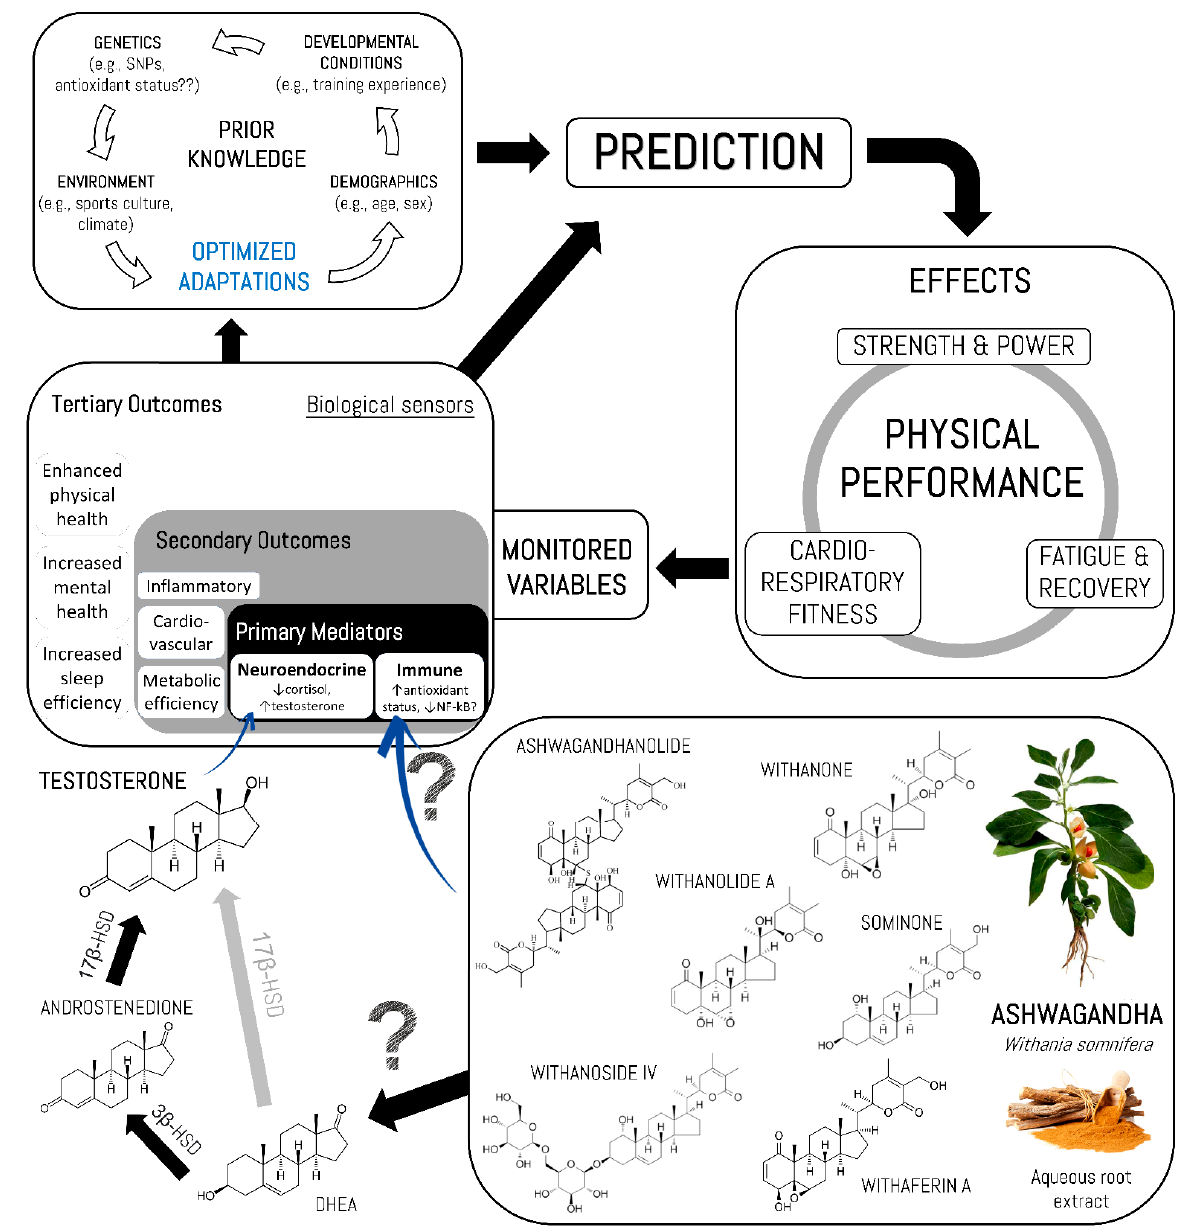
Figure 10. Potential mechanisms of action with feedback control of the Ashwagandha effects on physical performance variables. 3 β -HSD: 3 β -hydroxysteroid dehydrogenase; 17 β -HSD: 17 β -hydroxysteroid dehydrogenase; DHEA: dehydroepiandrosterone; SNP: single nucleotide polymorphism.